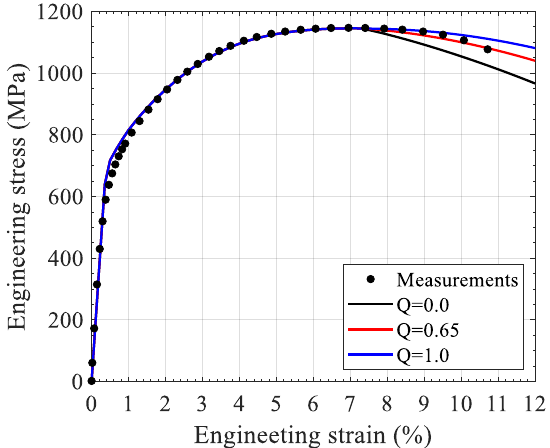
Figure 3. Engineering stress-strain responses measured from the tensile tests with a standard round specimen (ASTM E370) of SUJ2Z steel and those calculated from the FE simulation of the tensile tests.